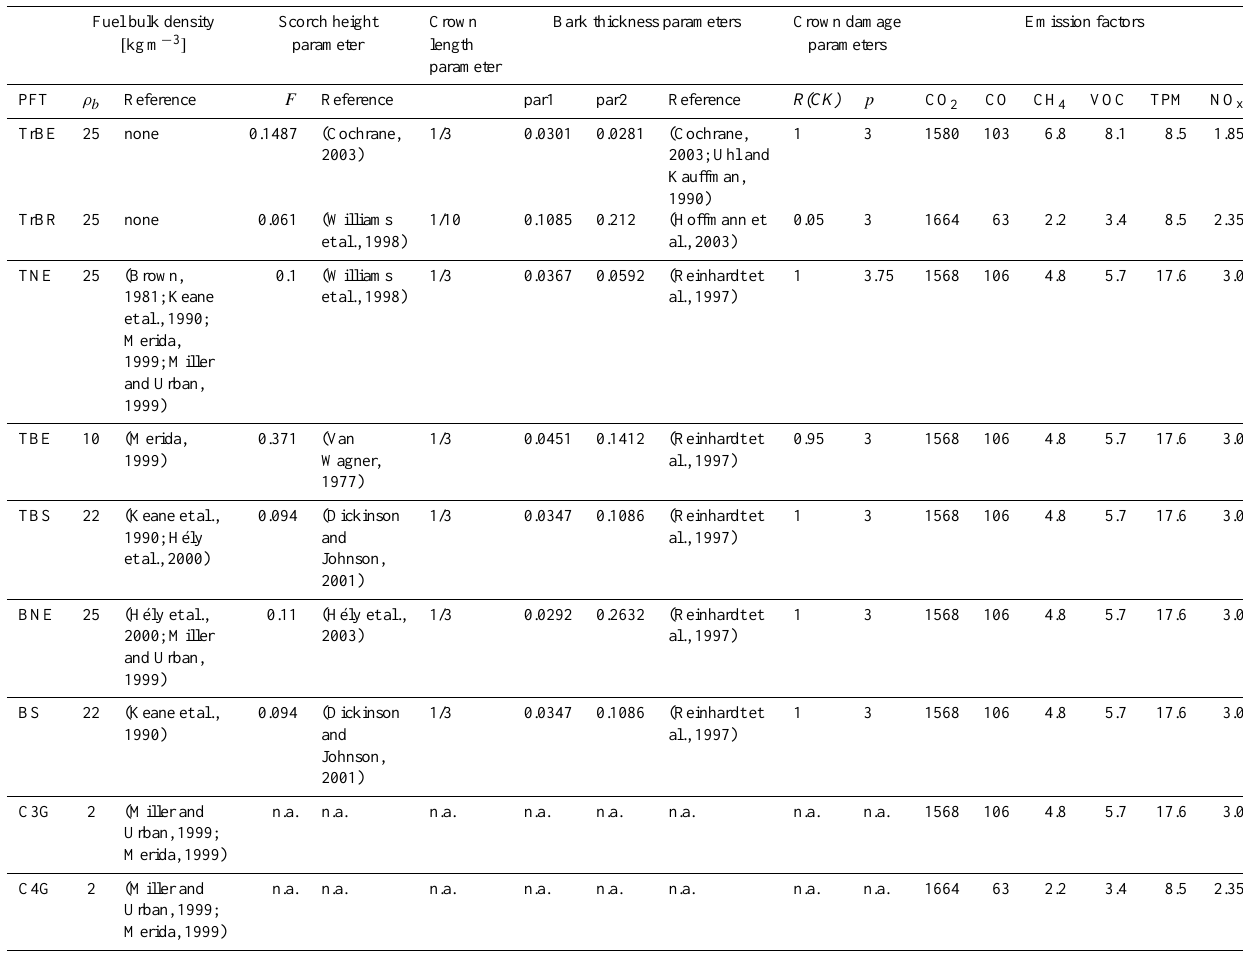
Table 1. PFT-specific model parameter values. TrBE: Tropical broadleaved evergreen, TrBR: Tropical broadleaved raingreen, TNE: Tem- perate needle-leaved evergreen, TBE: Temperate broadleaved evergreen, TBS: Temperate broadleaved summergreen, BNE: Boreal needle- leaved evergreen, BS: Boreal summergreen, C3G: C 3 grass/herbaceous, C4G: C 4 grass/herbaceous. Crown damage parameters R(CK) and p are taken from Peterson and Ryan (1986), Cochrane (2003) and Williams